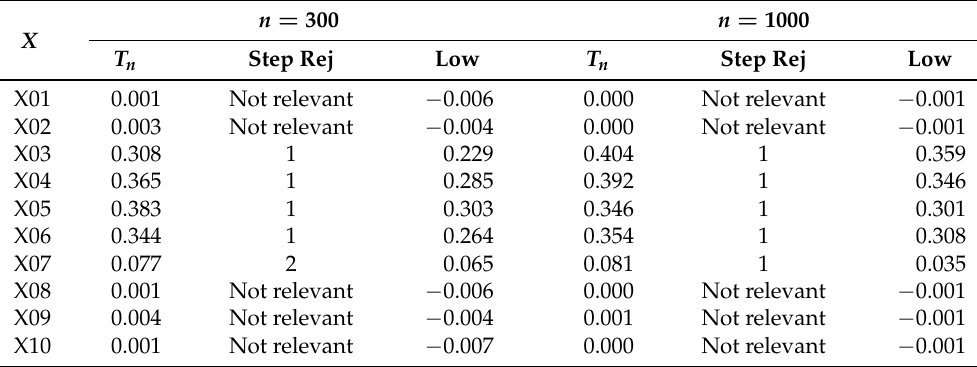
Table 5. Model M3 (Friedman), Test statistic T n , k -FWE rejection step (Step Rej), lower limits of the bootstrap confidence region (Low = T n − ˆ c ( 1 − α , k ) ) with B = 1999 replicates and nominal level 1 − α = 0.90, for n = 300, and n = 1000 observations.